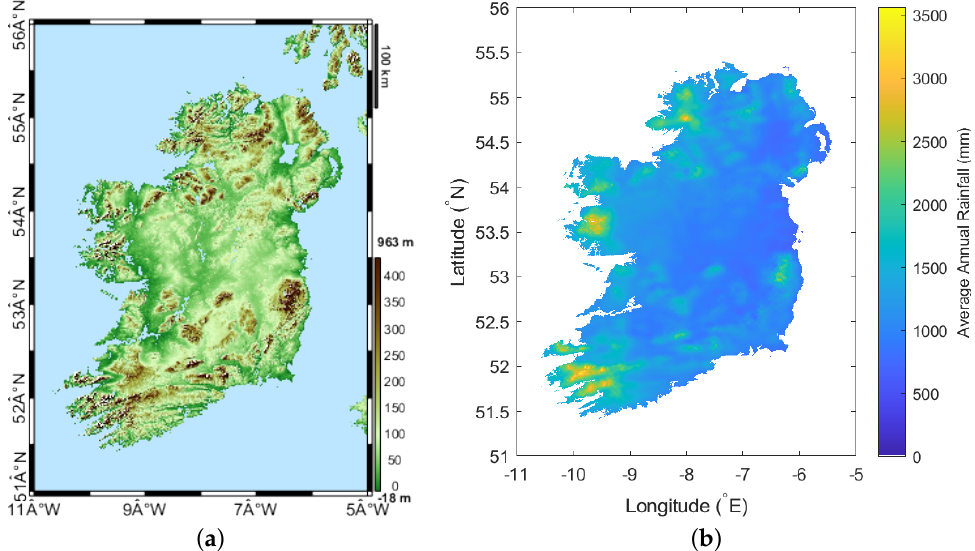
Figure 2. Topographical data ( a ) obtained from NASA and average annual rainfall data for the 30 year period 1981–2010 ( b ) obtained from Met Éireann [40] were mapped using the READHGT function [41] and MATLAB’s [42] imagesc function,